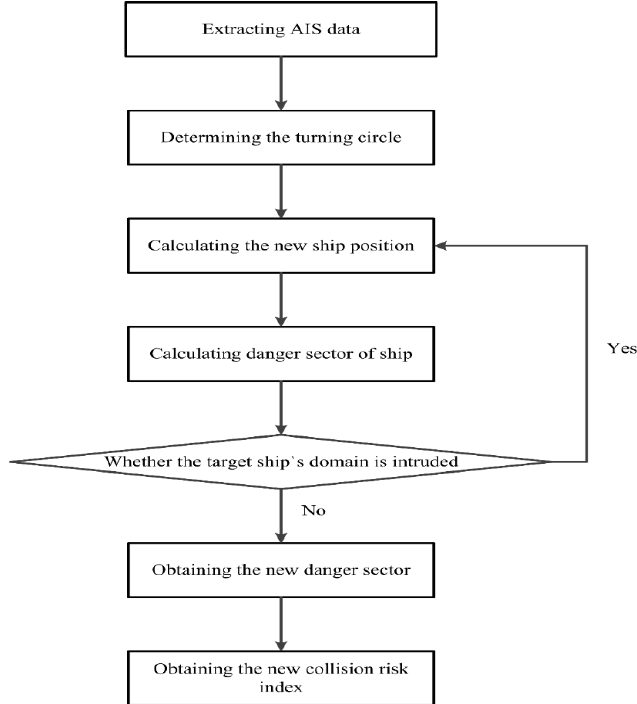
Figure 6. The flow chart of the proposed model.